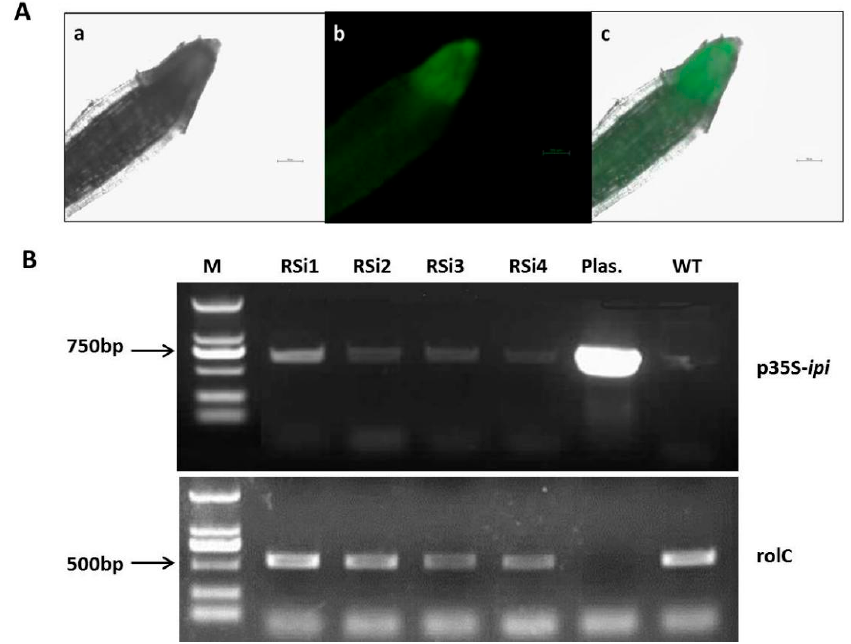
Figure 6. ( Aa ) under white light of fluorescence microscopy; ( Ab ) under blue excitation light of fluorescence microscopy; ( Ac ) superposition of white and blue light of fluorescence microscopy; ( B ) Representative PCR analyses for the presence of p35S- ipi and rolC genes in transgenic hairy root lines. M: DL-2000 marker (100–2000 bp); RSi: transgenic root lines; WT: the wild type of S. miltiorrhiza roots (negative control); Plas: the vector of pK7GWIWG2D- ipi (positive control plasmid).